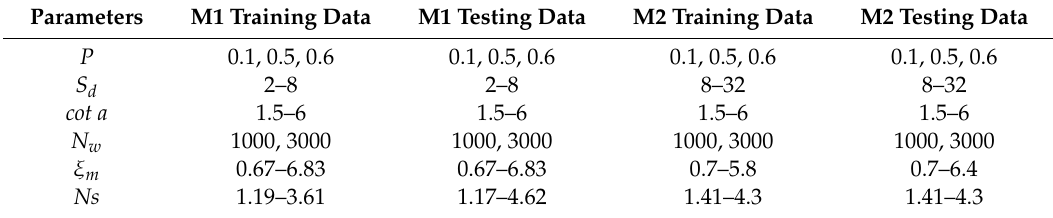
Figure 2. Parameters used in the M1 and M2 models: ( a ) the permeability of M1; ( b ) permeability of M2; ( c ) damage level of M1; ( d ) damage level of M2; ( e ) slope angle of M1; and ( f ) slope angle of M2. Table 2. The range of parameters used in the M1 and M2 models.